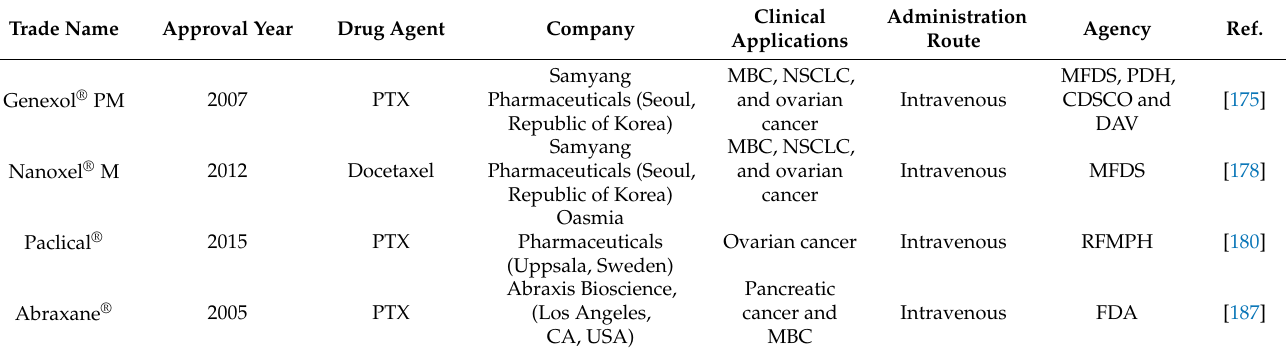
Table 3. Approved polymeric nanoparticle-based